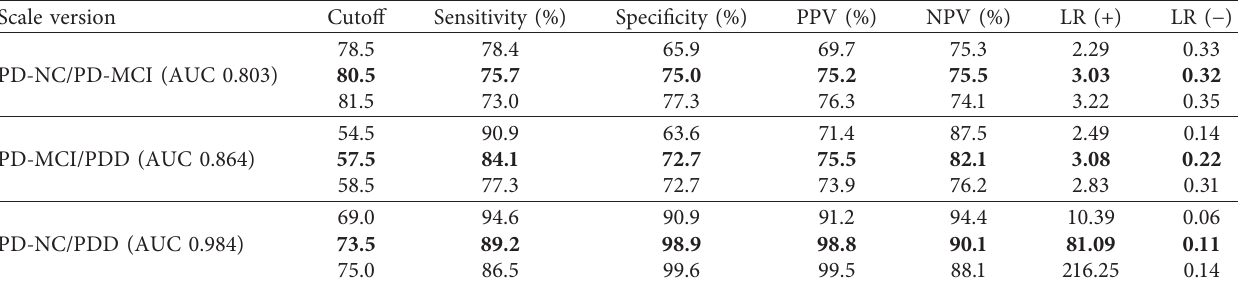
Table 6: Accuracy measures of